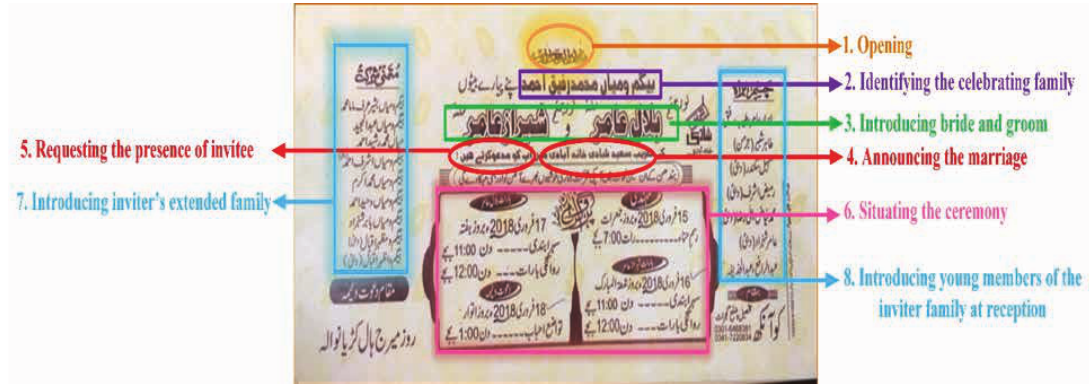
Figure 8: Moves in a generic structure of Pakistani wedding